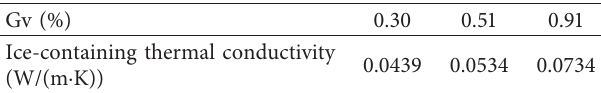
Table 11: Thermal conductivity of ice-containing peeled poly- urethane insulation board.